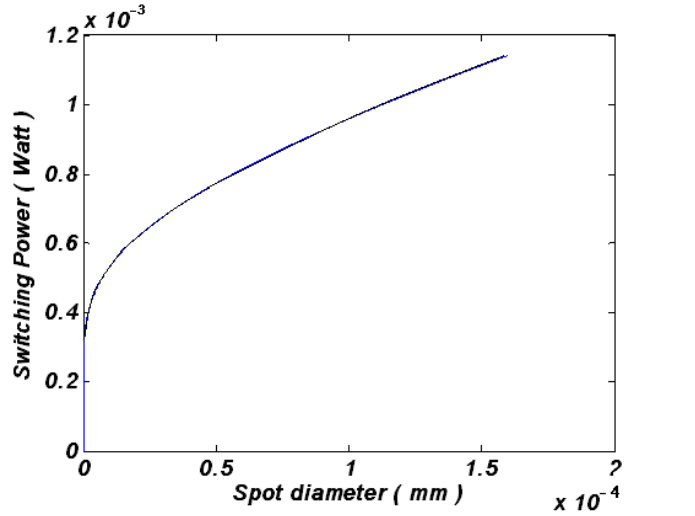
Fig.1: Switching power versus spot diameter calculated from eq.7 for a high finesse.